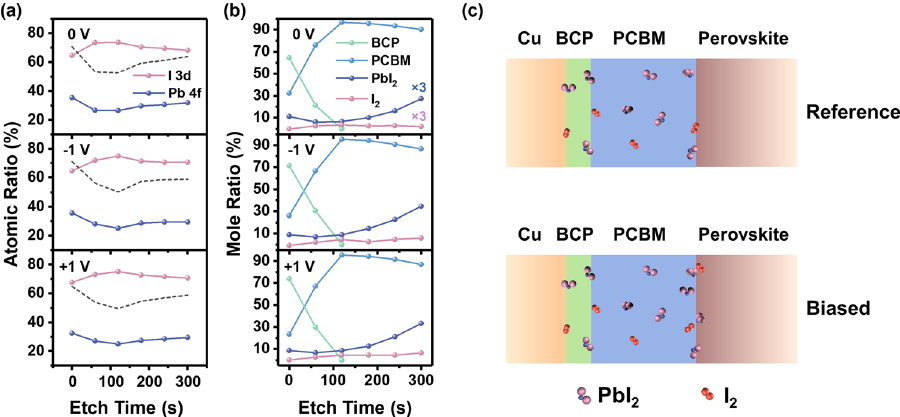
Fig. 2 The chemical constituent distributions as a function of sputtering time. a The relative concentration of Pb and I for the samples with and without electric stress (±1 V). The data points are based on two sets of samples. The sample-to-sample uncertainty is ±0.7% (0 V), ± 0.4% ( − 1 V) and ±0.4% ( + 1 V), respectively (seen in Supplementary Table 3). The dashed gray dash line represents the I stoichiometric ratio for the PbI 2 . b The molar ratios of the chemical constituents extrapolated from the elemental depth pro fi le in Fig. 1b – d. c Schematic diagram of mobile species throughout the multilayer stacks consisting of perovskite/PCBM/BCP/Cu. Mobile species such as PbI 2 and I 2 are marked as well.